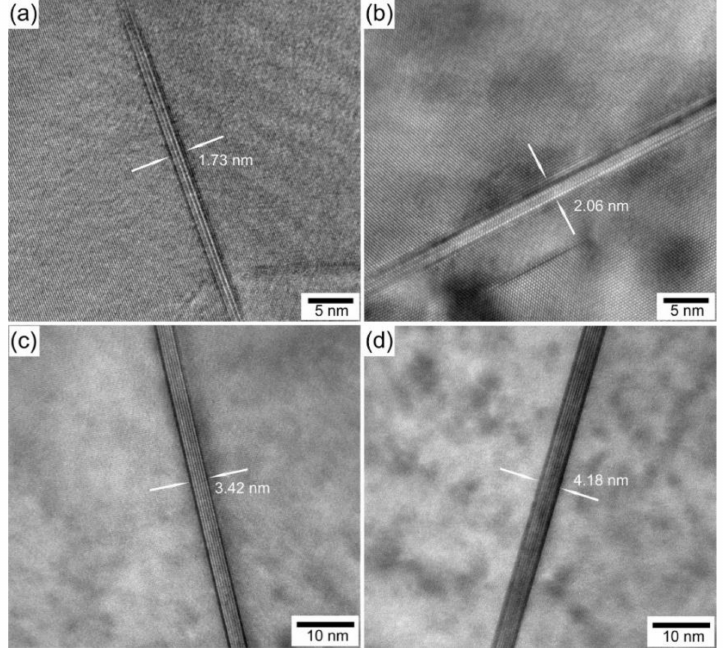
Figure 4. HRTEM images of Ω phases of the alloy with 6.00 wt % Cu ( a , b ) before, and ( c , d ) after the creep test at 200 ◦ C under 250